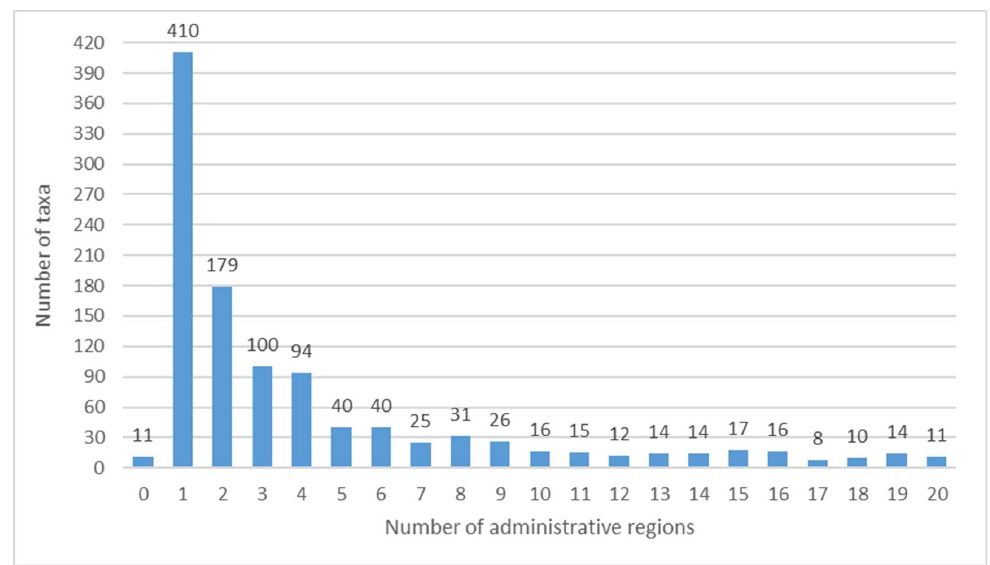
Figure 5. Number of administrative regions where the taxa have been cited.